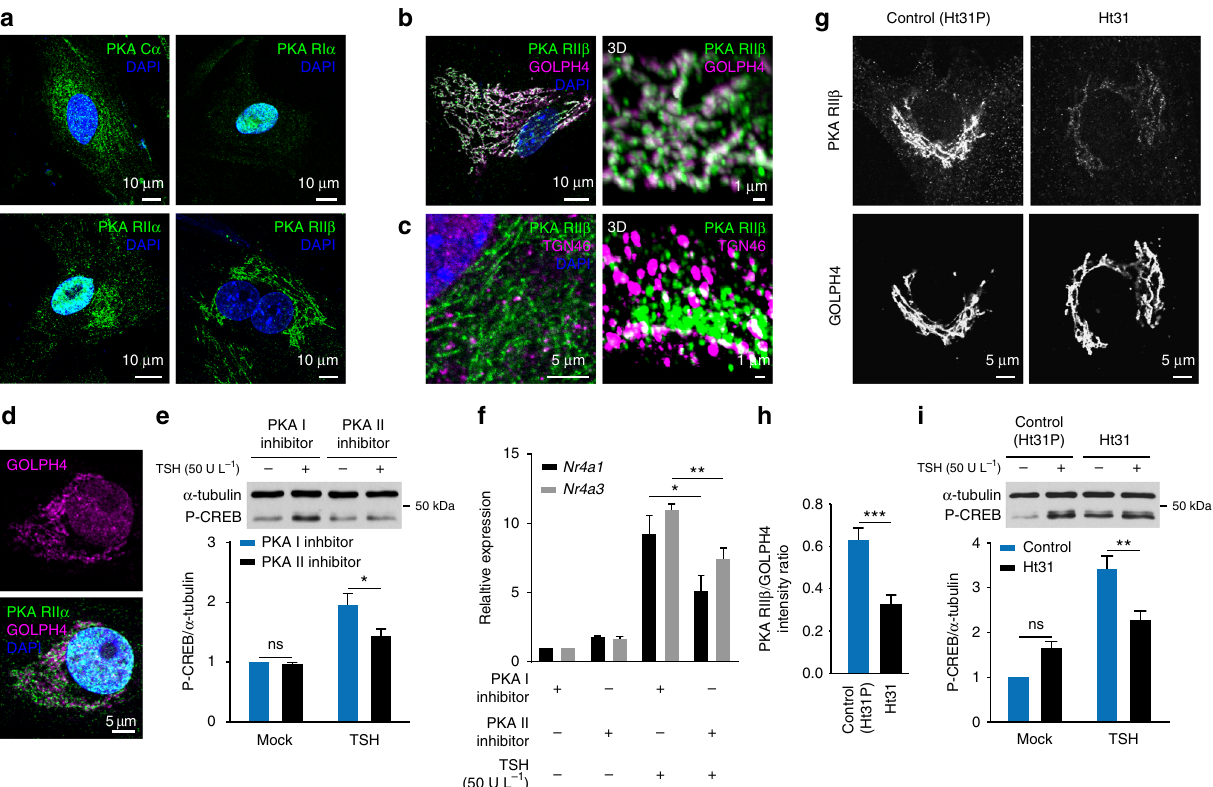
Fig. 4 PKA II activation and localization at the Golgi/TGN are required for ef fi cient TSH-dependent CREB phosphorylation a Subcellular localization of PKA subunits in primary mouse thyroid cells. The catalytic (C α ) and regulatory subunits (RI α , RII α and RII β ) of PKA were visualized by immuno fl uorescence with speci fi c antibodies. Nuclei were stained with DAPI. b , c Co-staining of RII β with antibodies against GOLPH4 ( b ) and TGN46 ( c ), showing selective localization of RII β subunit on membranes of Golgi and TGN, respectively. Left, C onfocal images. Right, 3D reconstructions from confocal image stacks (see Supplementary Fig. 7). d Co-staining of RII α with GOLPH4, showing preferential localization of RII α at the Golgi. e Western blot analysis of CREB phosphorylation (Ser133) in response to TSH in cells pretreated for 1 h with a PKA I (Rp8-Br-cAMPS, 250 μ M) or PKA II (Rp8-Br-PIP-cAMPS, 250 μ M) inhibitor. α -tubulin was used as loading control. Data (mean ± S.E.M, n = 3) are expressed relative to those in the mock-stimulated sample pretreated with PKA I inhibitor. f Induction of early genes in response to TSH in cells pretreated for 1 h with PKA I/II inhibitors. Data (mean ± S.E.M, n = 4) are expressed as in e . g Effect of Ht31 or Ht31P (control) peptides (20 μ M, 1 h) on the Golgi localization of RII β . Shown are representative RII β and GOLPH4 immuno fl uorescence stainings acquired with same contrast settings. h Quanti fi cation of images as in g . RII β intensity values (mean ± s.e.m., n = 12/20) are expressed relative to those of GOLPH4. i Western blot analysis of CREB phosphorylation (Ser133) in cells pretreated for 1 h with Ht31 or Ht31P (20 μ M) and stimulated with TSH. Data (mean ± s.e.m., n = 3) are expressed relative to those measured in the mock-stimulated control sample. Differences in e , f and i are statistically signi fi cant by two-way ANOVA. * P < 0.05, ** P < 0.01, by Bonferroni ’ s post hoc test. Difference in h is statistically signi fi cant